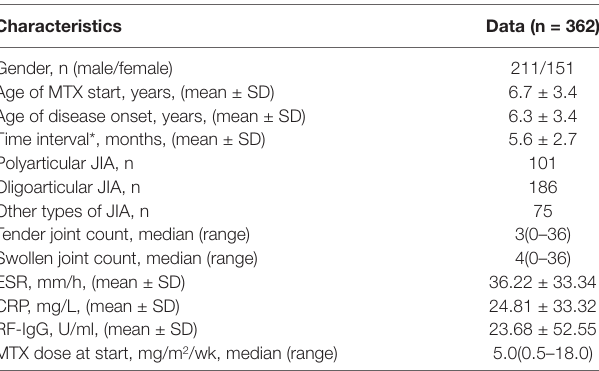
TABLE 2 | Baseline patient